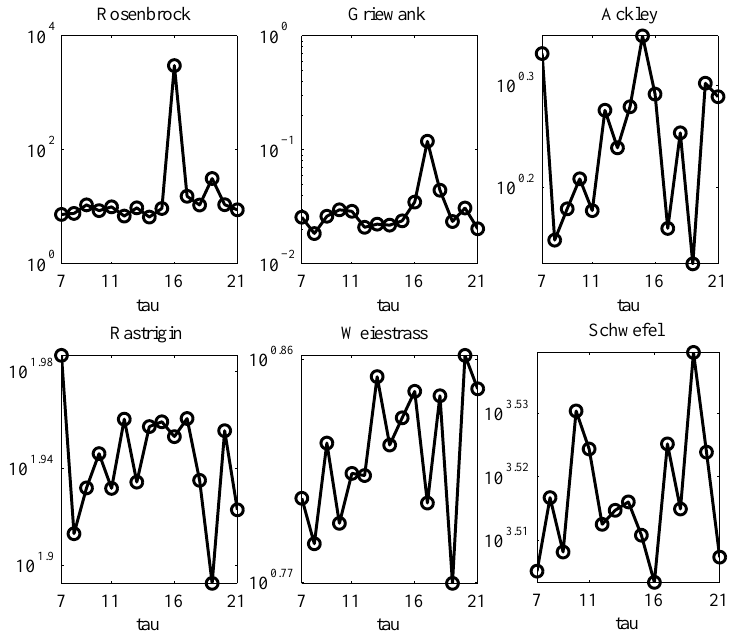
Figure 3: The variance of the final fitness value of PSO against the parameter τ (tau) on the six benchmark